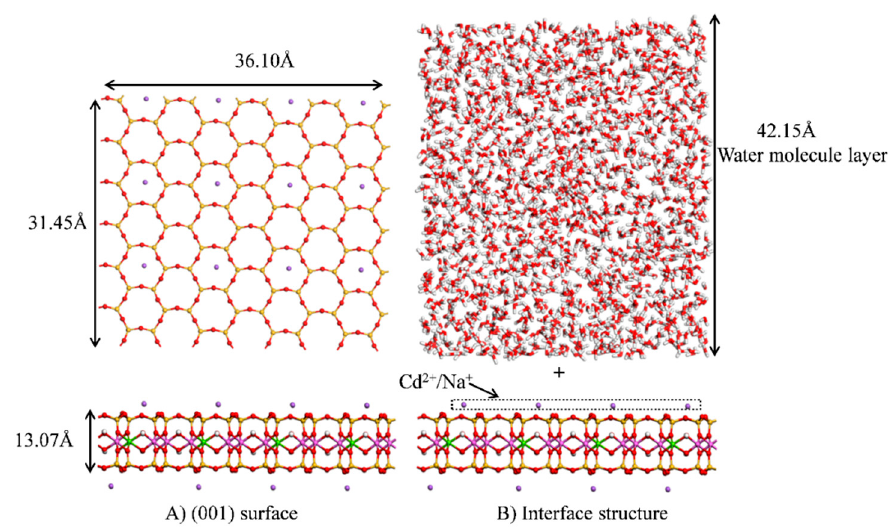
Figure 2. Montmorillonite surface: ( A ) (001) surface and ( B ) interface structure.